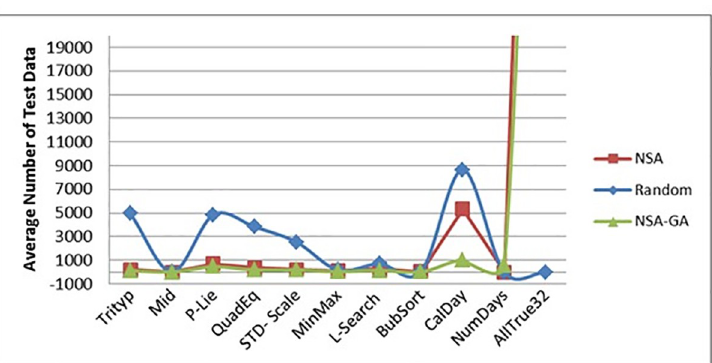
Fig 10. Average number of test data recorded for random testing, NSA and NSA-GA methods for all benchmark programs.